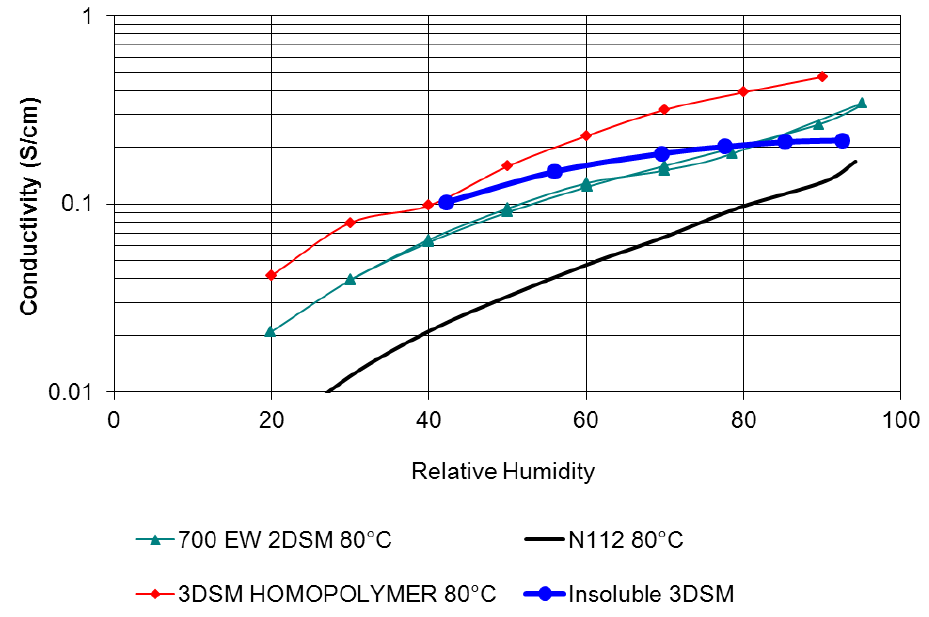
Figure 8. Comparison of conductivity between Giner’s PFSA-filled 2DSM over a range of relative humidity (RH) vs. Nafion 112 ®